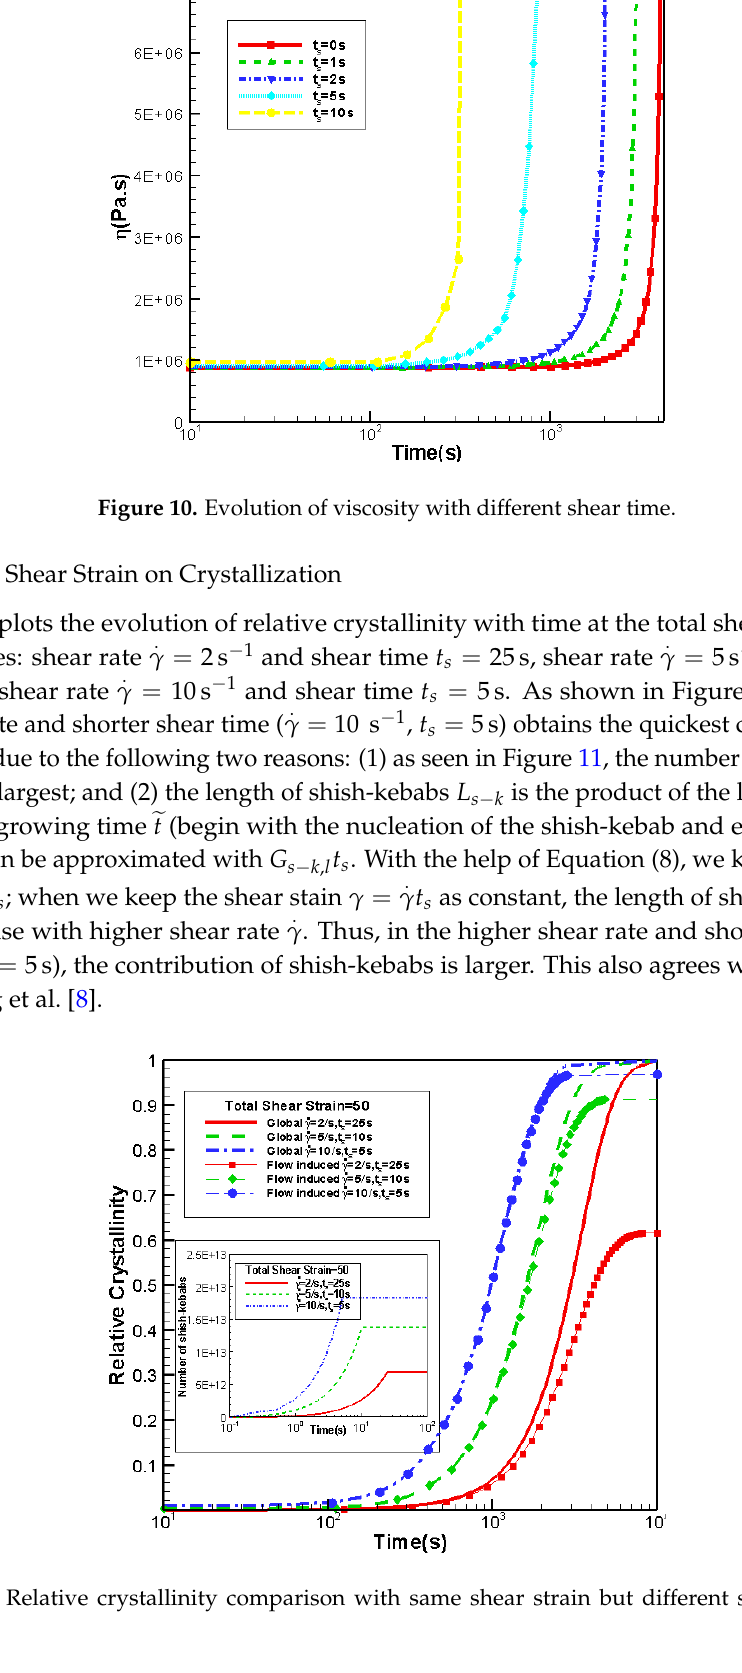
Figure 12. Evolution of viscosity with same shear strain but different shear rate and shear time. 4. Conclusions A morphological Monte Carlo simulation is carried out to calculate the crystallization kinetics and capture the crystal morphology in 3D simple shear flow. Effects of shear rate, shear time and the shear strain on crystallization kinetics, crystal morphology and rheology of the system are discussed. The conclusions are drawn as follows.